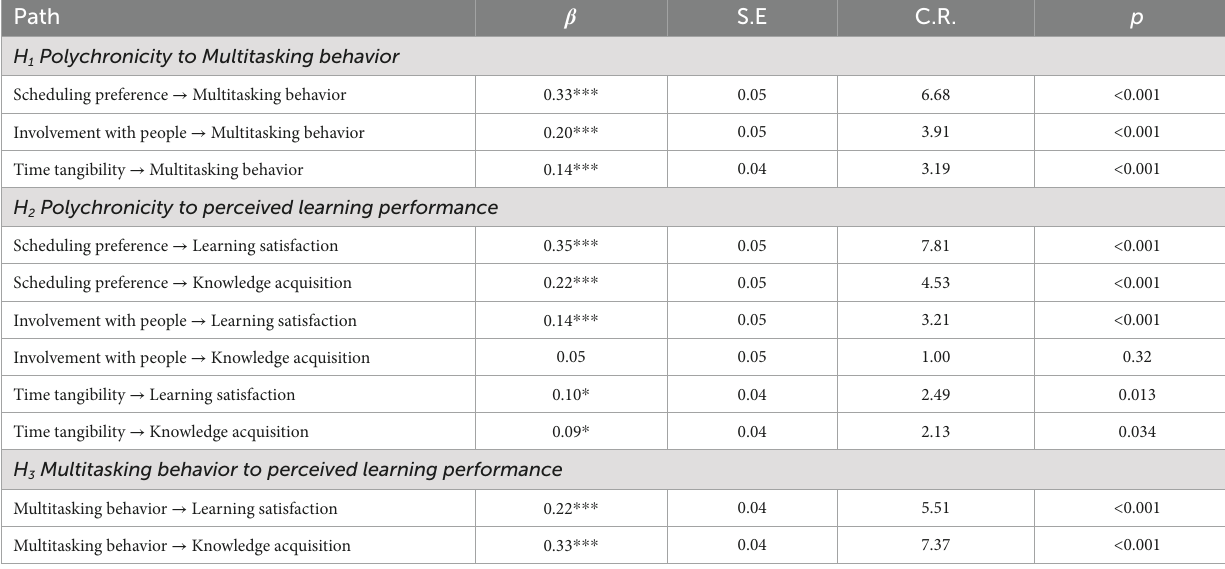
TABLE 1 Path relationships among multitasking behavior, polychronicity, and perceived learning performance ( n = 865). Path